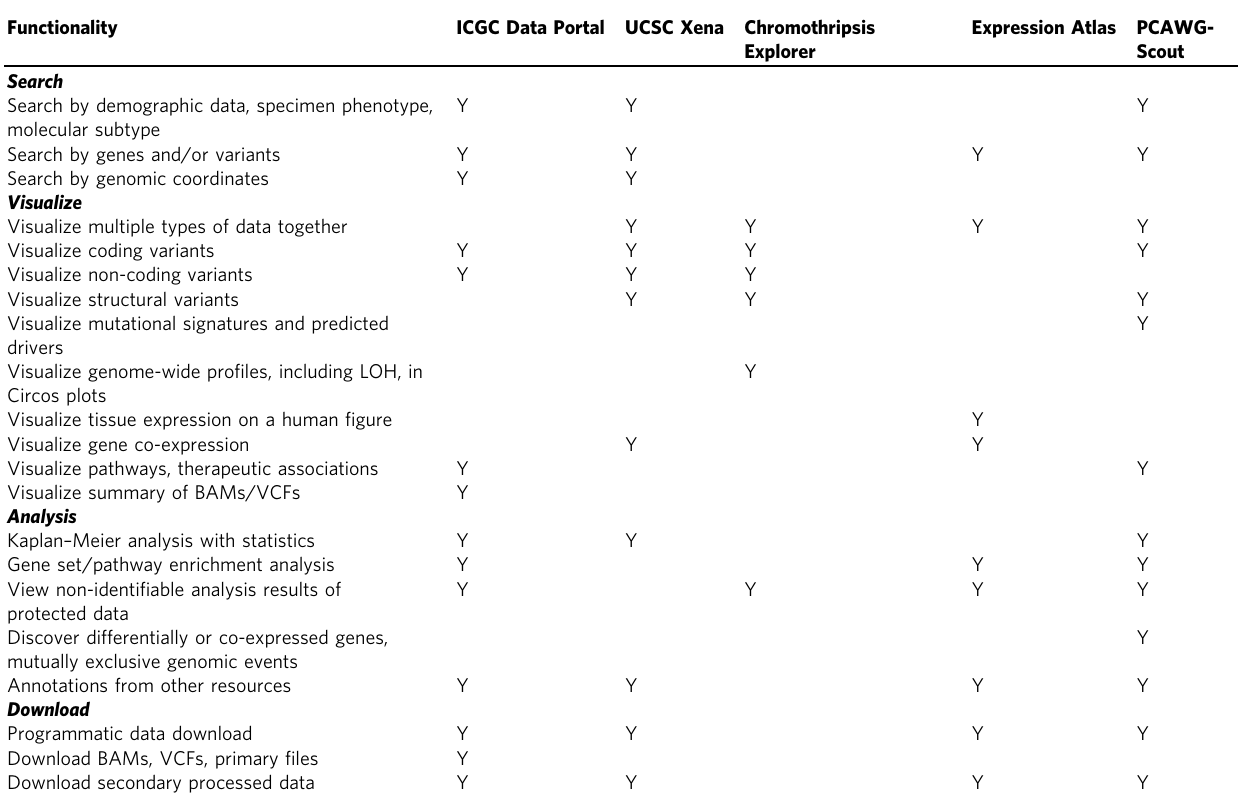
Table 1 Search, visualization, analysis/integration, and download functionalities provided by each of the PCAWG data